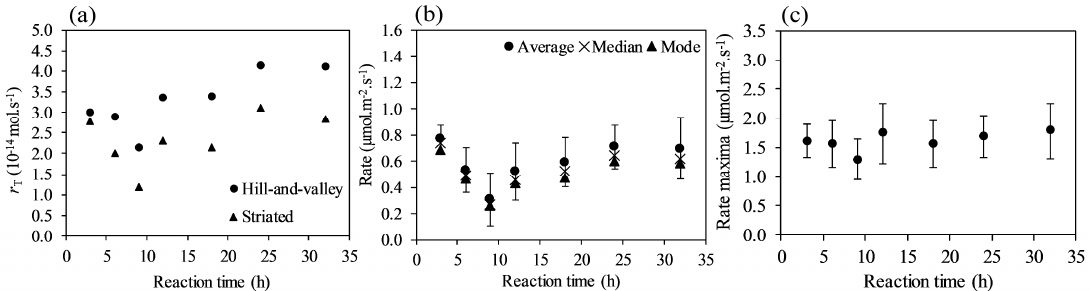
Figure 7. Compilation of the rate of dissolution of ten calcite-filled sandstone pores: ( a ) Total material flux ( r T ) normalized to the size of the calcite patches (standard deviation was omitted for better visualization), selection of the two categories was made by qualitative observation of the reacted surface morphologies; ( b ) central statistical parameters (average, median and mode); ( c ) rate maxima. All rate values were calculated from the sub-section rate maps shown in Figures S14–S23 of Supplementary Material.